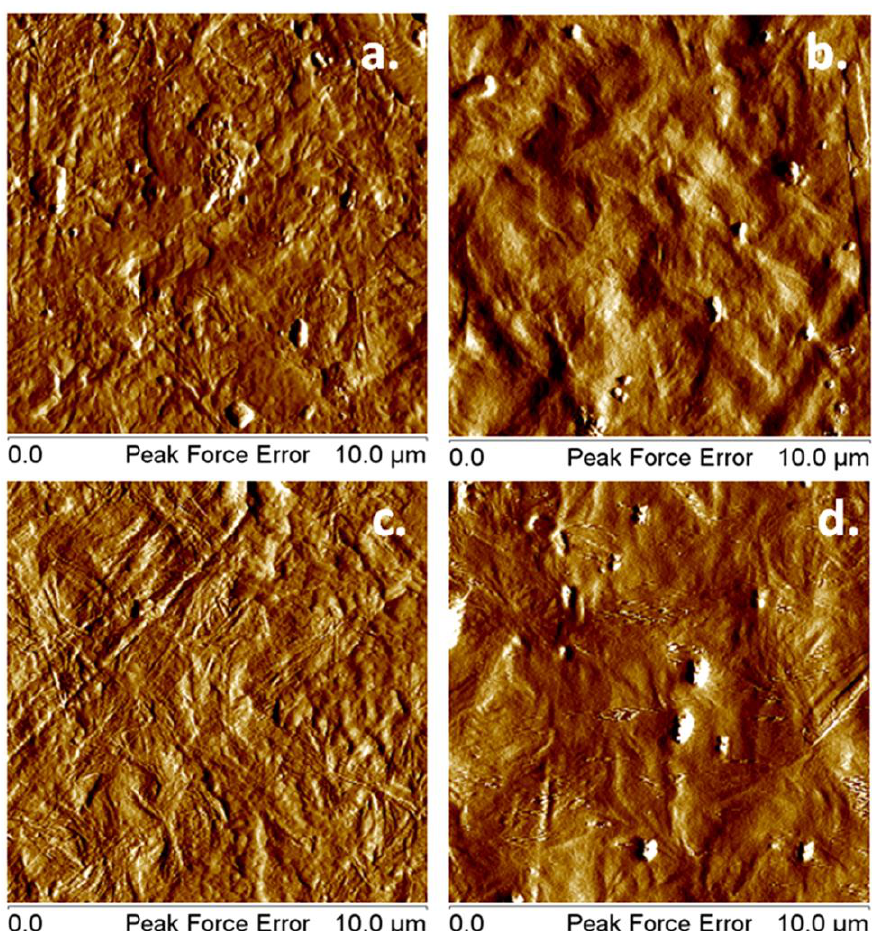
Figure 11. AFM peak force error images of PHB and PHB-5BC before ( a , c ) and after the plasma treatment ( b , d ).